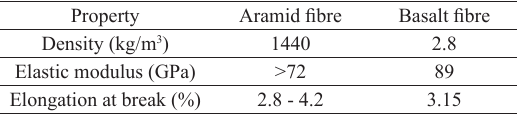
Table 1. Material properties of aramid and basalt